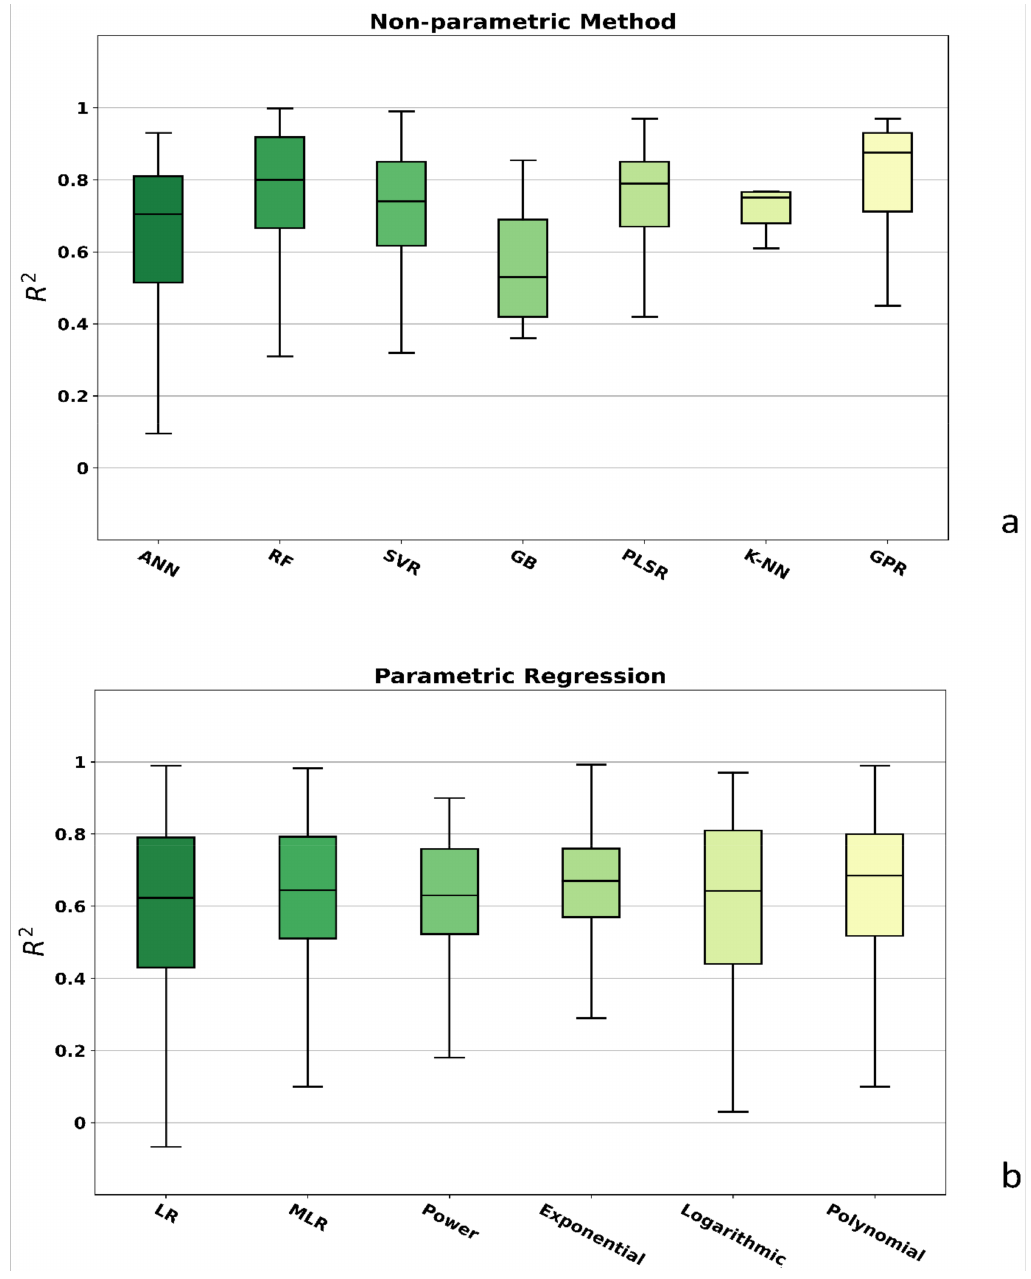
Figure 17. The coefficient of determination of ( a ) non-parametric algorithms and ( b ) parametric regression models. LR: Linear Regression; MLR: Multiple Linear Regression; GPR: Gaussian Pro- cess